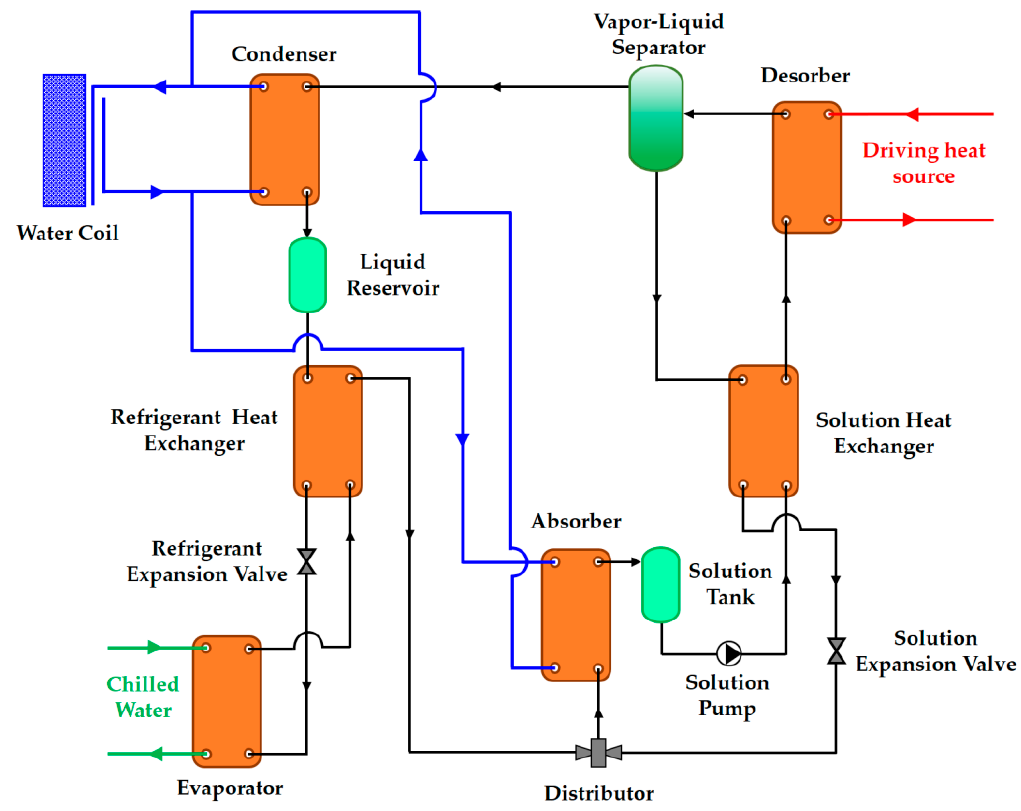
Figure 13. Schematic diagram of the single ‐ effect ammonia/LiNO 3 absorption cycle of the Zamora et Schematic diagram of the single-e ff ect ammonia / LiNO 3 absorption cycle of the al. [57] pre ‐ industrial prototype. Adapted from Reference [57]. Zamora et al. [57] pre-industrial prototype. Adapted from Reference